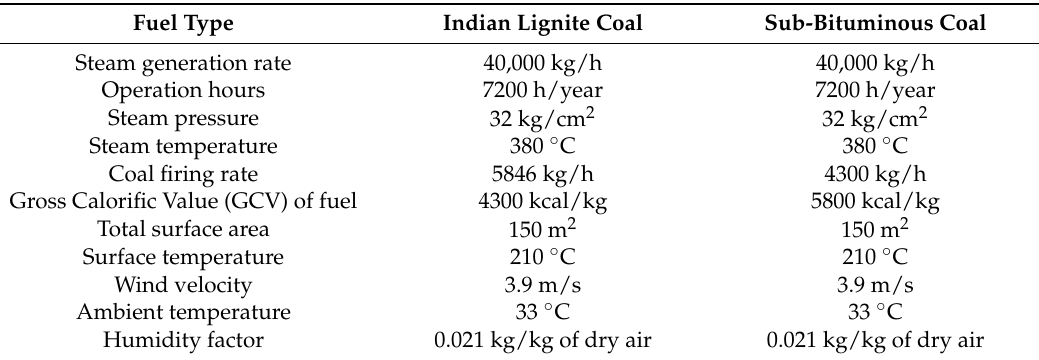
Table 3. The operating data of the